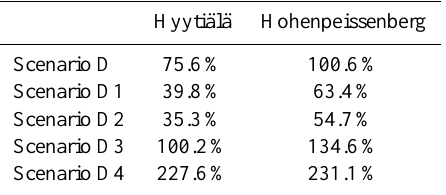
Table 5. Sensitivity studies on the different reaction rates between the stabilized Criegee intermediates and water on the overall sCI contribution to form sulfuric acid in the atmosphere. Explanations of the different scenarios are provided in Sects. 3 and